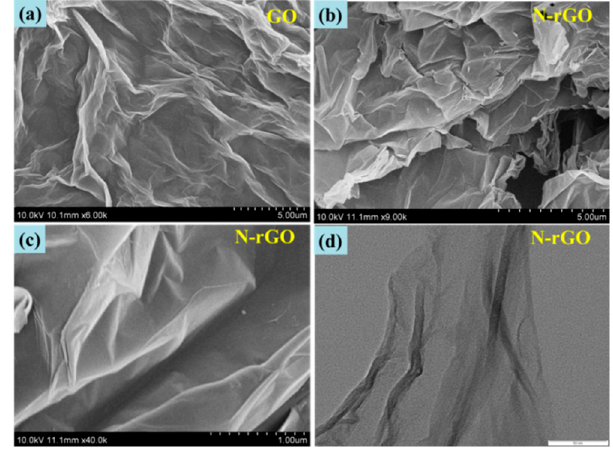
Figure 2. The SEM image of the GO ( a ) and N-rGO ( b , c ). The TEM image of N-rGO ( d ).